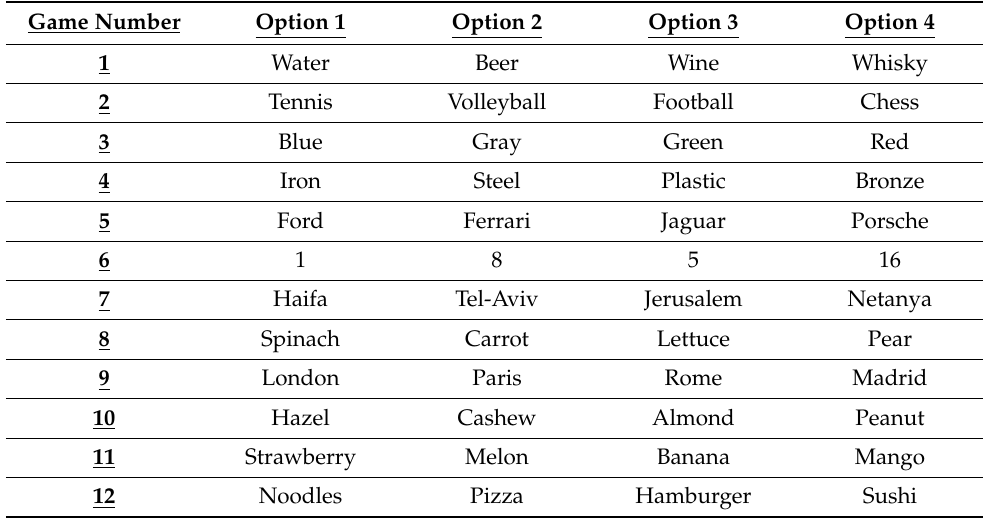
Table A1. Experimental game